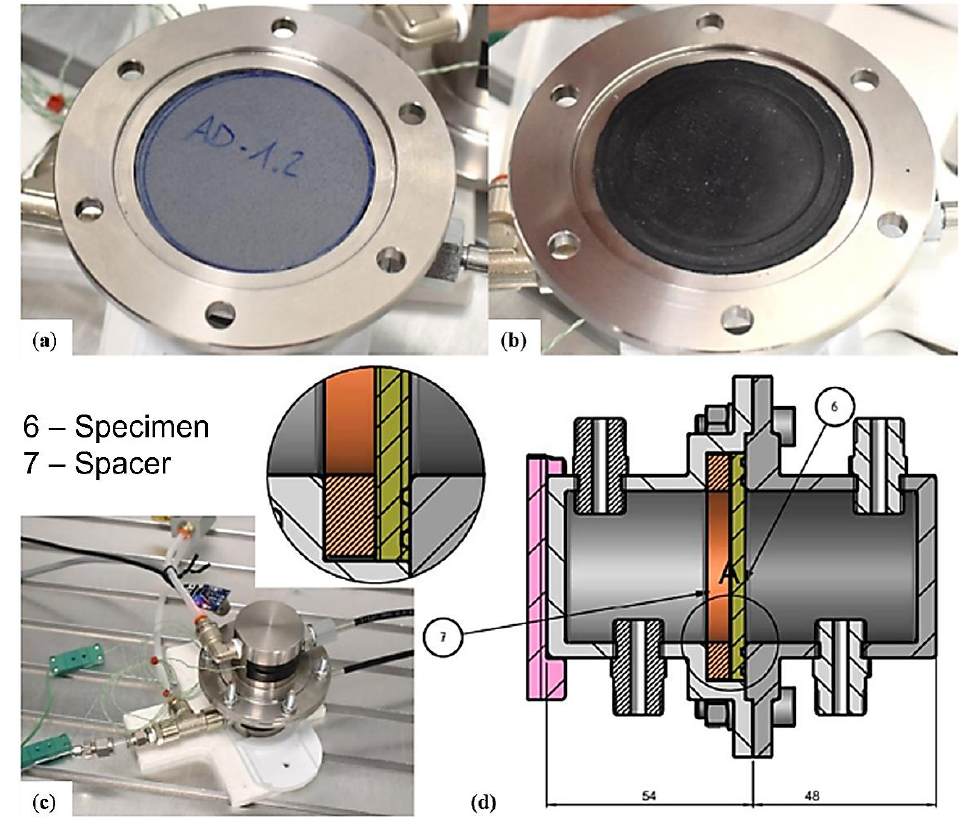
Figure 4. Assembly of the hydrogen permeability test apparatus. ( a ) Advantseal specimen. ( b ) Cristalcar specimen. ( c ) Test chamber with hydraulic connections. ( d ) Test chamber’s lateral section.